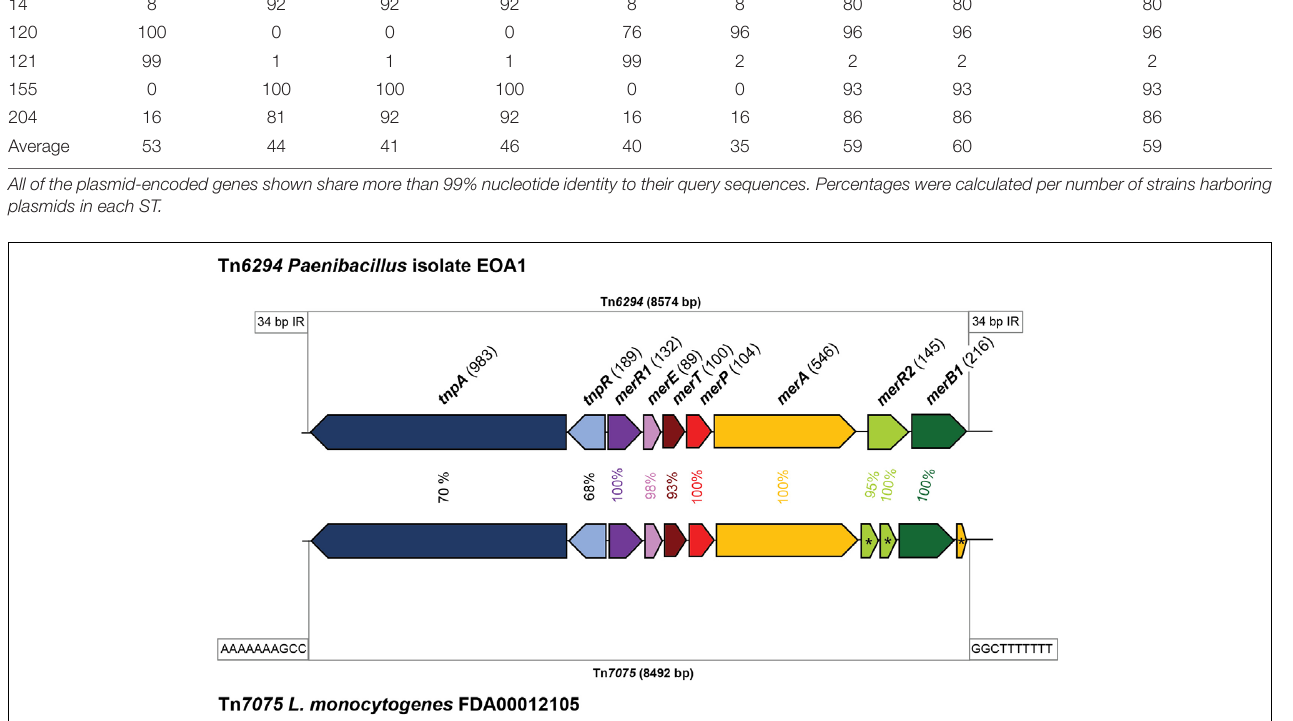
FIGURE 5 | Genetic organization and similarity of mercury resistance transposons. The mercury resistance transposon Tn 6294 from the Paenibacillus strain EAO1 (Matsui et al., 2016) and the transposon Tn 7075 found on the putative plasmid in Listeria monocytogenes FDA00012105 are shown. Homologous genes are shown in the same color. Putative pseudogenes are indicated by an asterisk (*). The inverted repeats flanking the transposons are